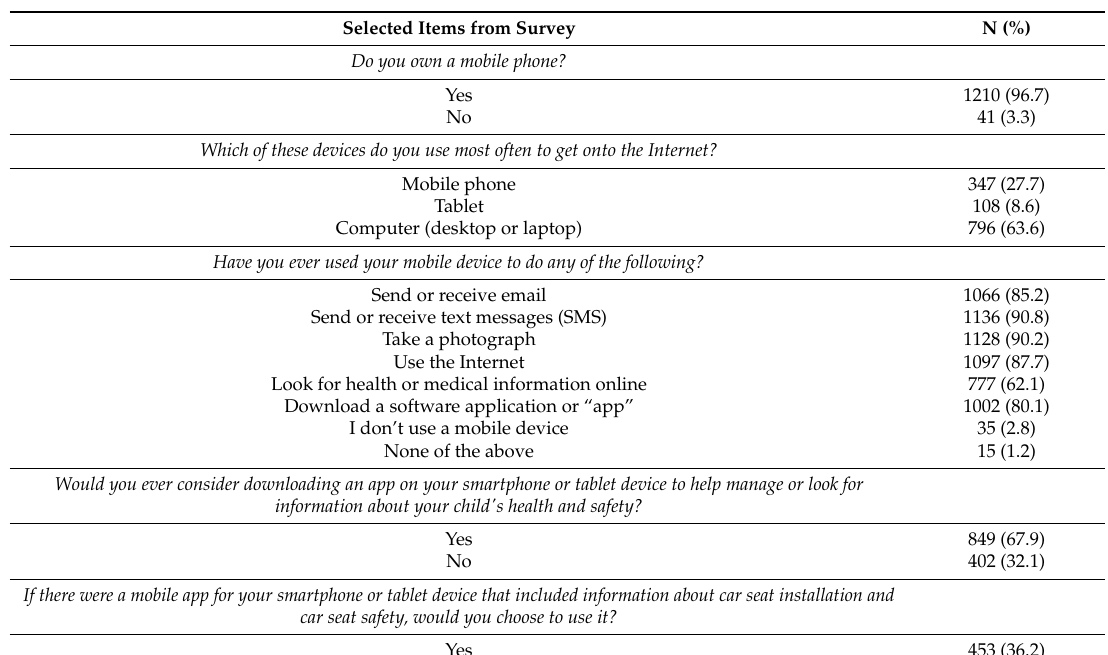
Table A4. Parents’ use and preferences around digital media and devices. Selected Items from